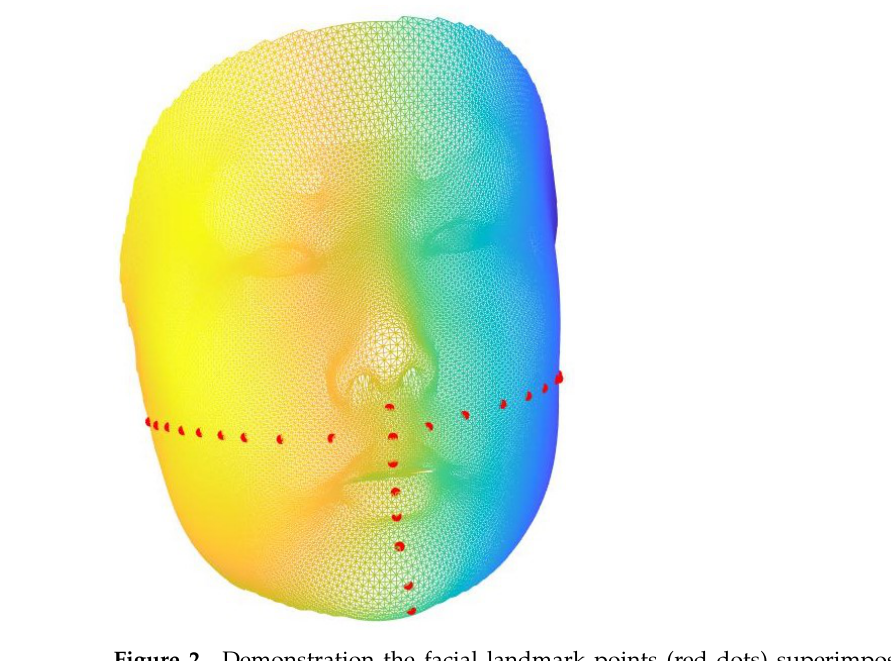
Figure 2. Demonstration the facial landmark points (red dots) superimposed on a sample 3D face model.